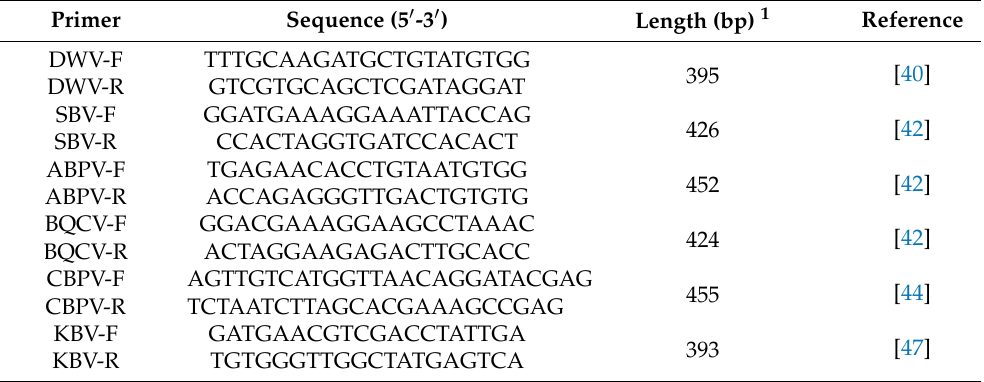
Table 1. Primers used for RT-PCR detection of honey bee-associated